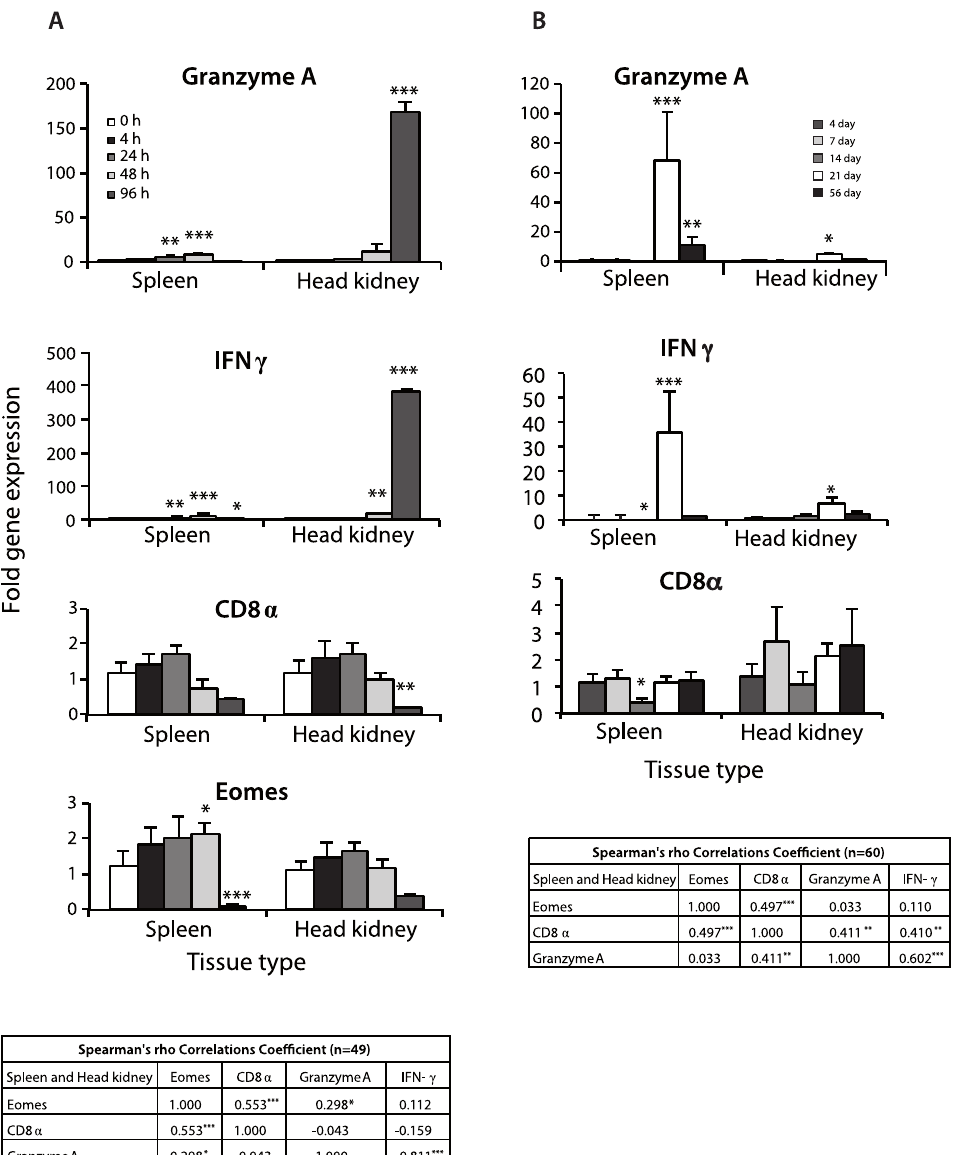
Figure 5. Invivo regulation of Eomes expression in Atlantic salmon post infection. (A) Tissue specific expression of granzyme A, IFN- c , CD8 a , and Eomes at different time-points after A. salmonicida challenge, and the overall correlation between them shown from top to bottom respectively, in the left panel. (B) Tissue specific expression of granzyme A, IFN- c , CD8 a , at different time-points after IPN virus challenge, and the overall correlation between them including Eomes shown from top to bottom respectively, in the right panel (Eomes expression not shown since there was no significant differences). Data were normalized to EF-1 a expression at each time-points and presented as mean 6 S.E.M (n=6). Statistical differences ( P , 0.05, P , 0.01, and P , 0.001) between different time-points compared to control are indicated by asterisk (*, **, and ***) respectively, above the bars.